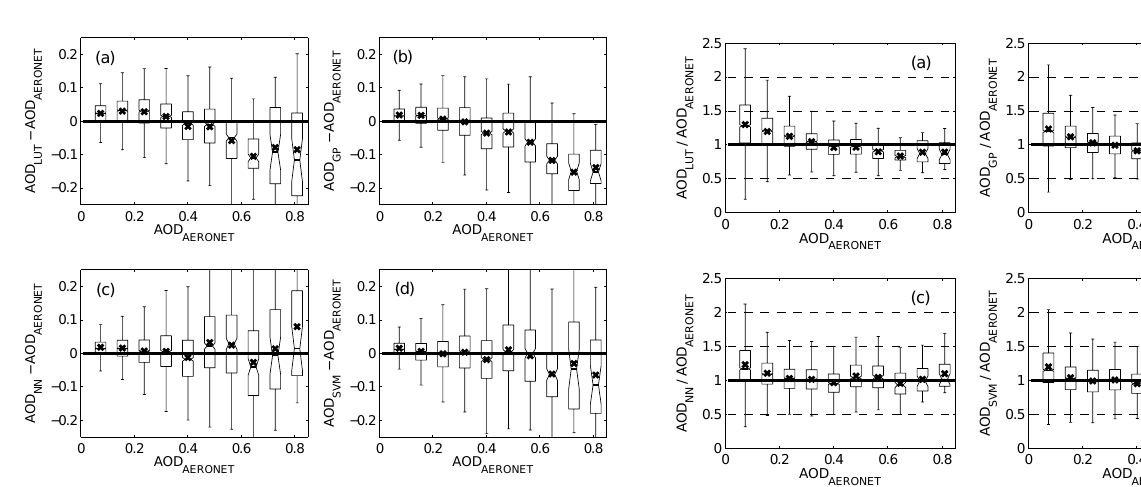
Figure 3. The same as Fig. 2, but the vertical axis indicates the ratio of the predicted to the observed (AERONET)